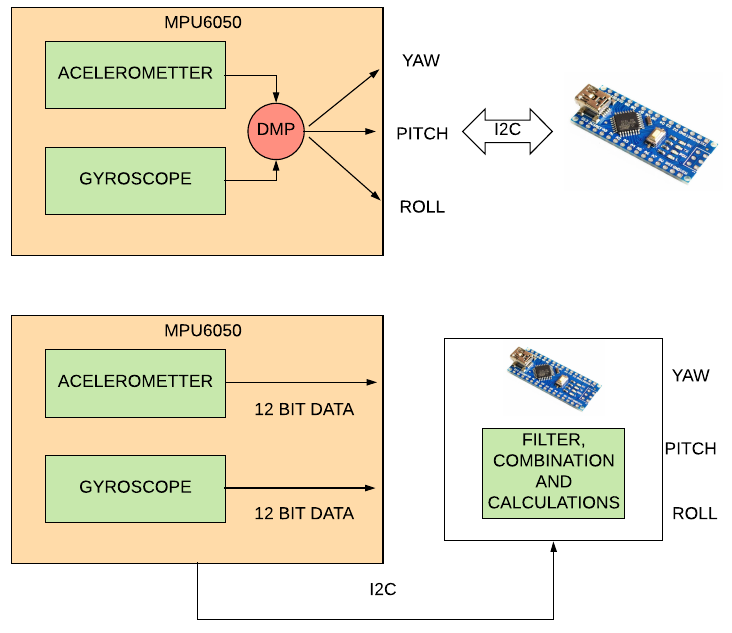
Figure 4. Advantage in the use of DMP.